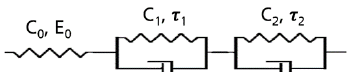
Figure 4. Schematic representation of two-mode Kelvin–Voigt mode.